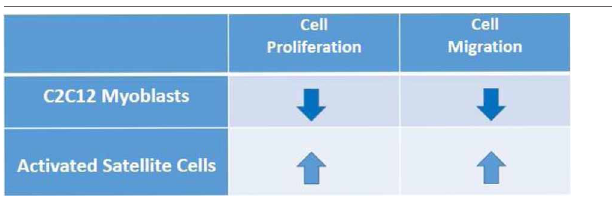
Table 1 | Role of sphingosine 1-phosphate on cell proliferation and migration in myoblasts and activated satellite